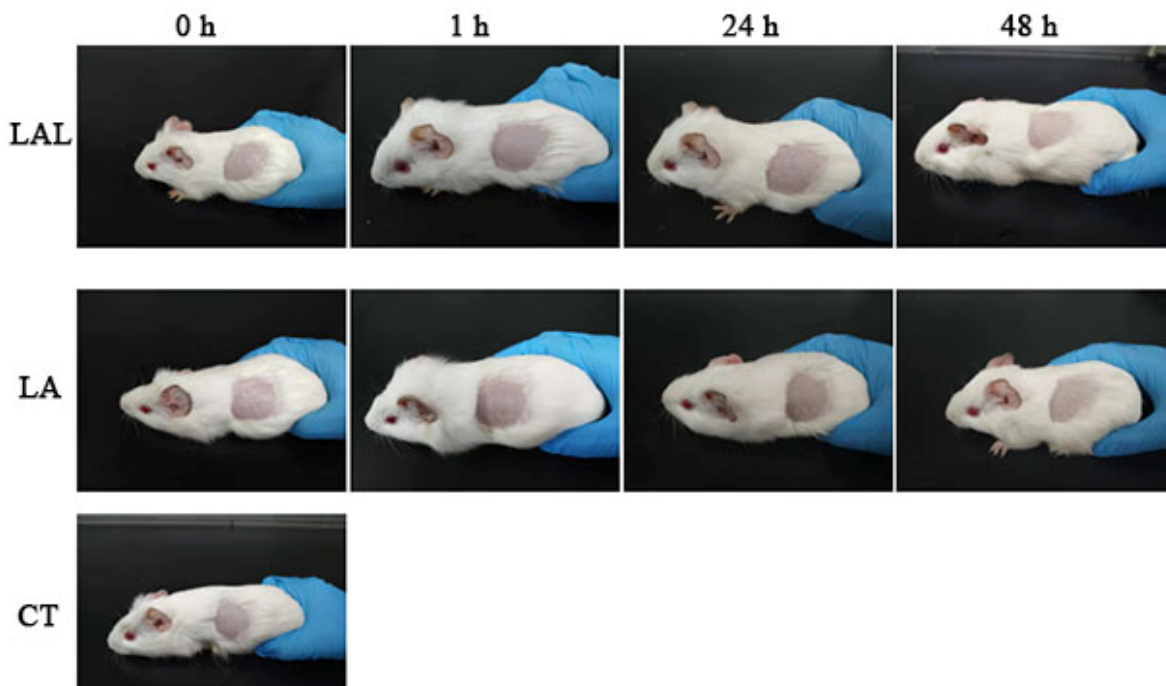
Figure 7. Photograph of the abdomens of guinea pigs exposed to the various